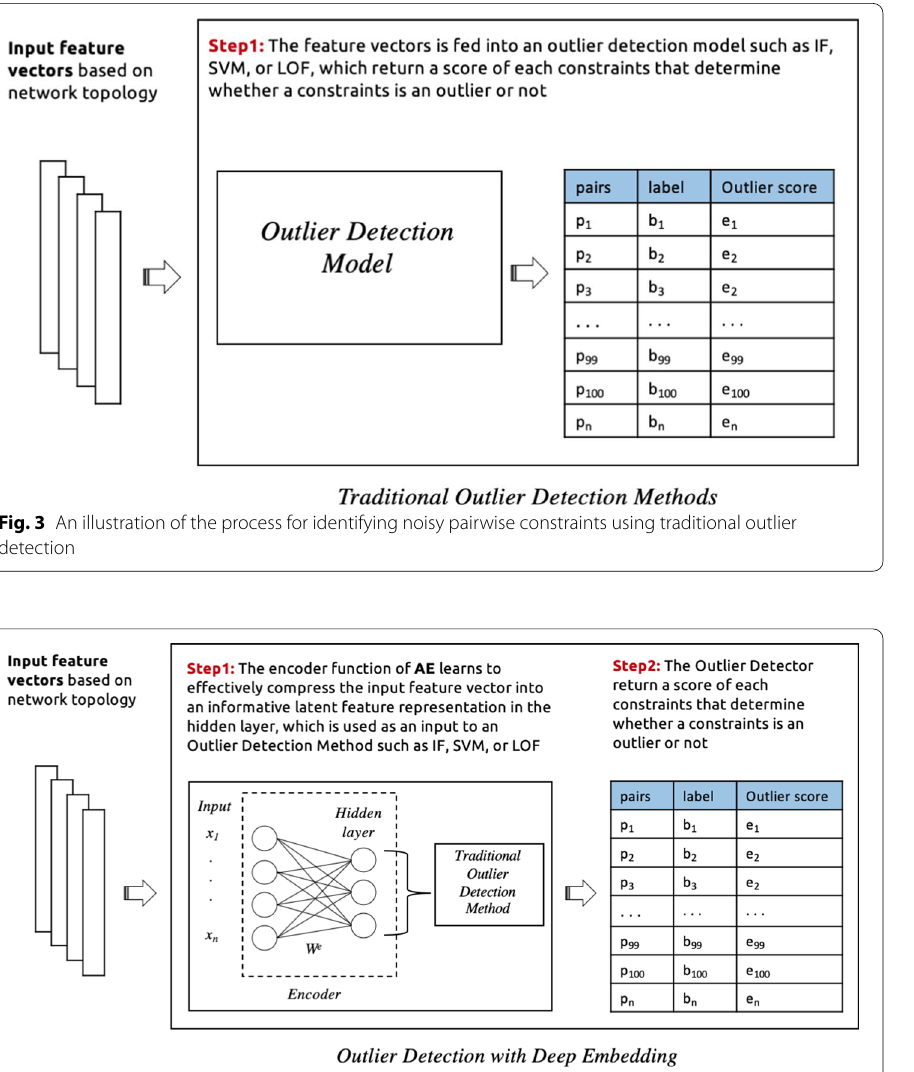
3 Deep learning approach: In this case, the neural network autoencoder (AE) is used as an outlier detection technique for identify noises in pairwise constraints. Differ- ent autoencoder models is used for must-link and cannot-link pairs separately. The feature vectors are fed into the autoencoder model, which learns to reconstruct the original constraints from the latent representation. The reconstruction error is given by the difference between the original constraints and the reconstruction. A large error is indicative of an outlier (i.e. a noisy constraint), while a low error indicates a “normal” example (i.e. a correctly-labelled constraint). Finally, we sort the constraints in ascending order (lowest to highest error) in order to determine the top k con- straints with the lowest level of error. The expectation is that, as the larger part of pairwise constraints are non-noisy, the autoencoder’s latent representation will be